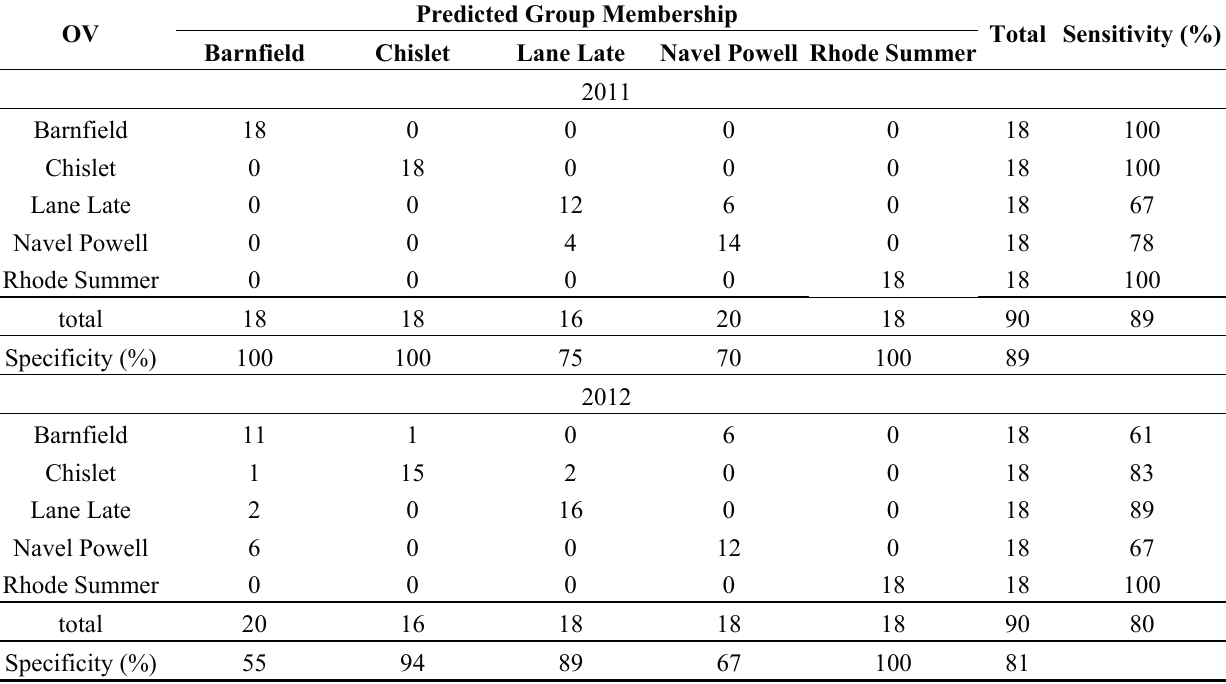
Table 2. Contingency matrix obtained using linear discriminant analysys based on antioxidant activity and antioxidant contents of sweet orange varieties